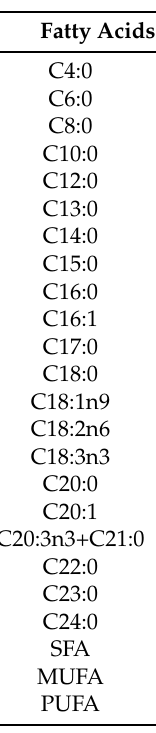
Table 1. Individual compounds in T. impetigosa inner bark (Mean ˘ SD).